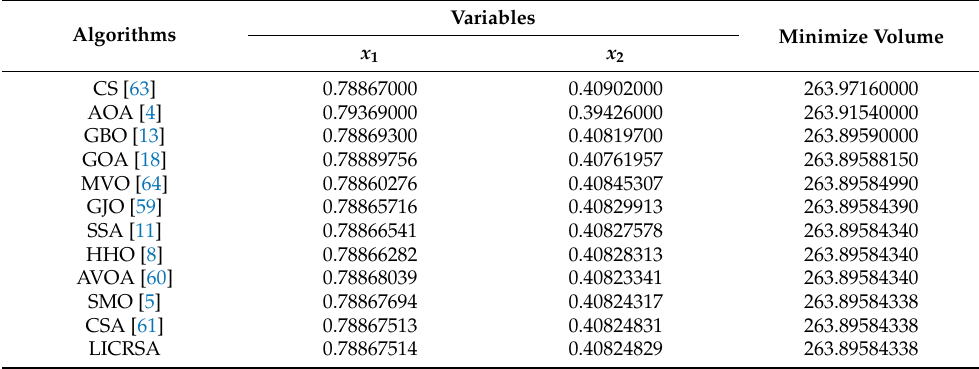
Table 15. Numerical comparison of the results obtained for the three-bar truss design in the